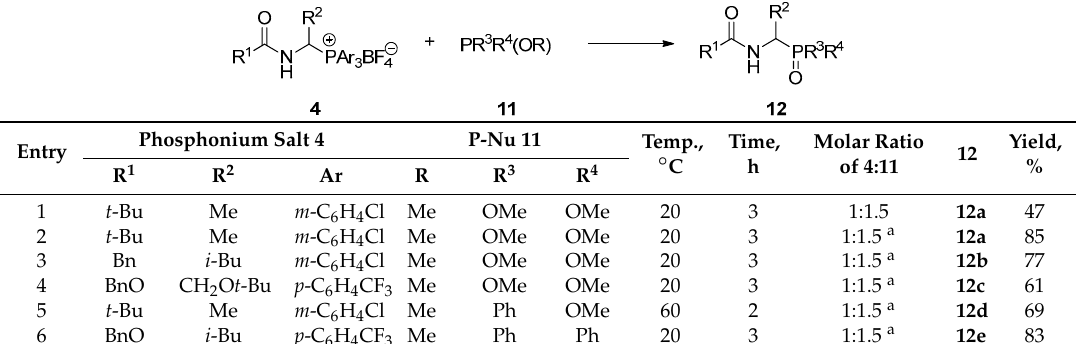
Phosphonium Salt 4 P-Nu 11 Temp.,